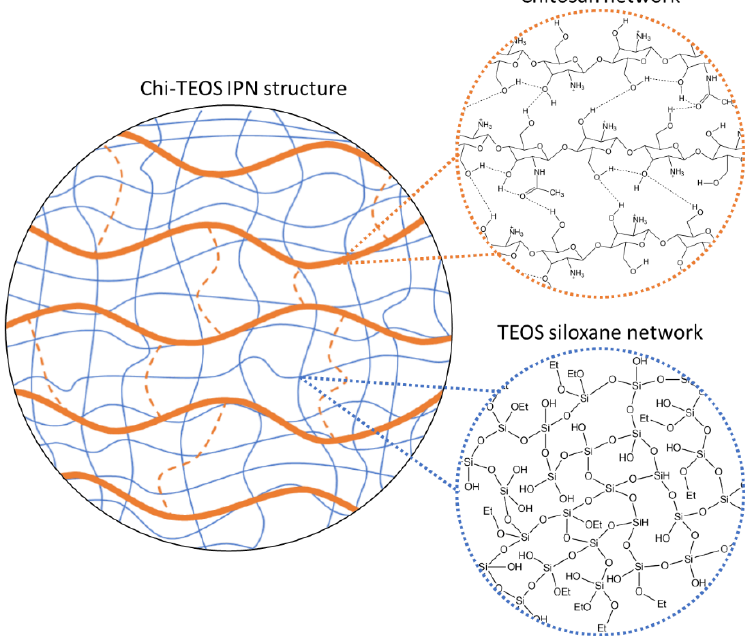
Figure 4. A schematic representation of the formation of a Chi-TEOS IPN.